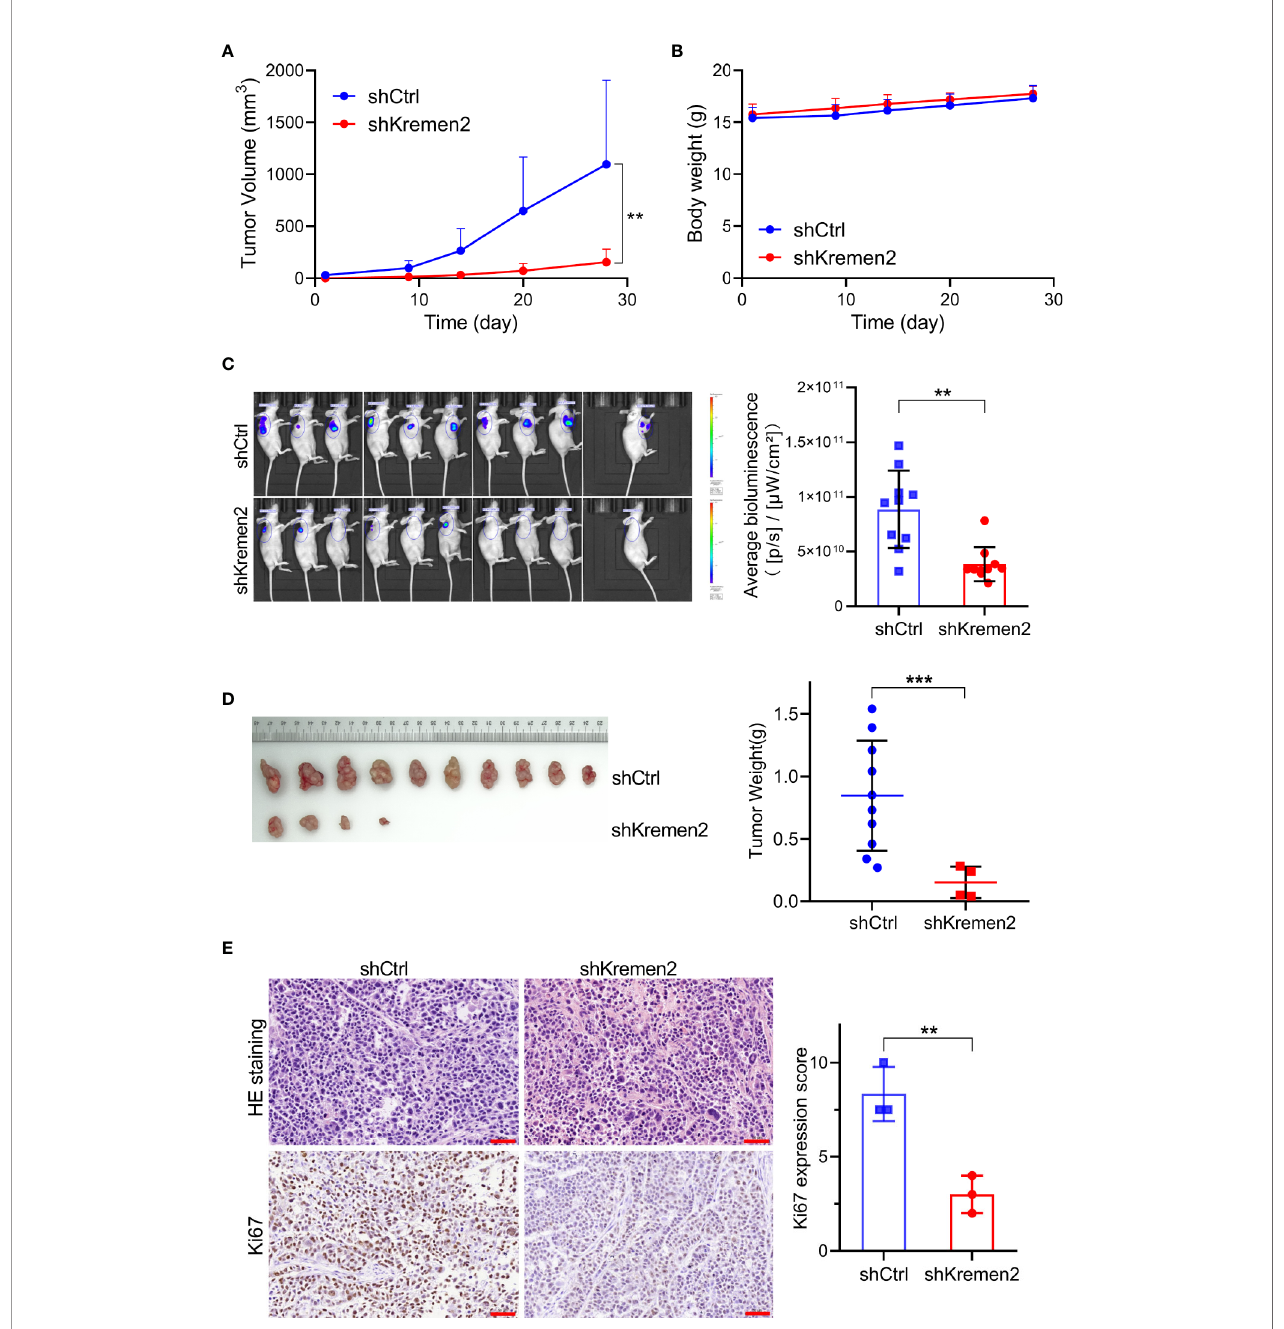
FIGURE 6 | Kremen2 knockdown repressed tumorigenicity of gastric cancer cells in vivo. Transfected GC cells expressing luciferase were subcutaneously injected to establish xenografts. Data including tumor volume and bodyweight were collected every two days. At the end of the in vivo study, bioluminescence was observed via an in vivo imaging system. (A) Tumor volume. (B) Body weight of nude mice. (C) In vivo imaging weight of tumor at the end of experiment (Day 28). (D) Tumors and tumor weight at the end of experiment. (E) H&E and Ki67 analysis of paraf fi n-embedded tumor tissues, and Ki67 expression score was calculated. ** P < 0.01; *** P < 0.001. Scale bar is 50 m